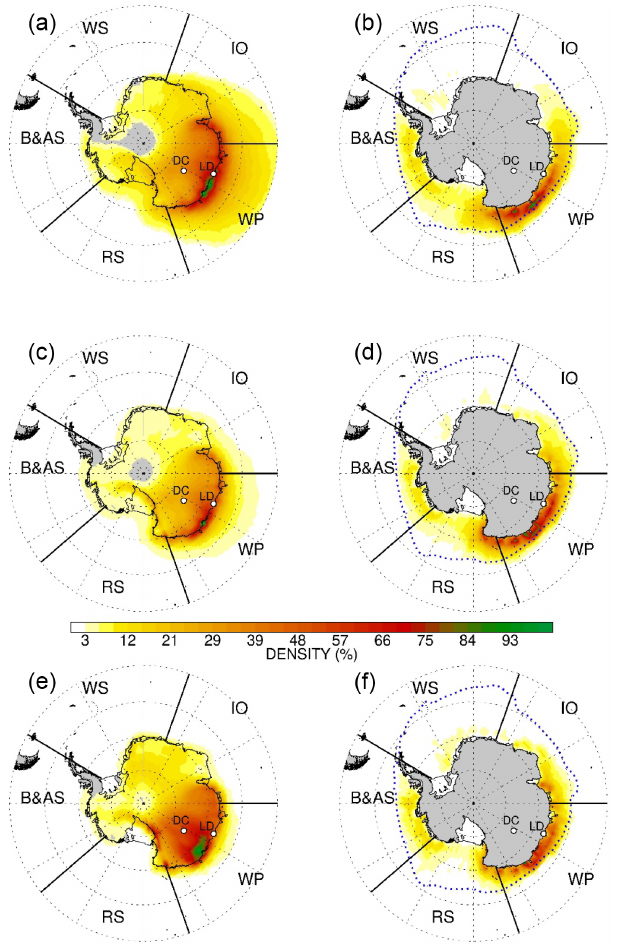
Figure 1. Five-day back-trajectory analysis of air masses arriving at the Dome C site for the period 1979–2018. The back trajectories are calculated at (a, b) 1000m, (c, d) 2000m, and (e, f) 3000m above Dome C model terrain height for the period 1979–2018. Maps are divided into five sectors: Indian Ocean (IO, 20–90 ◦ ), western Pa- cific Ocean (WP, 90–150 ◦ ), Ross Sea (RS, 160–230 ◦ ), and Belling- shausen and Amundsen seas (B and A, 230–20 ◦ ). Panels (a) , (c) , and (e) represent the sum of the total number of backward-trajectory points (i.e. hours) within the fifth and the second days found in each 1 ◦ × 1 ◦ grid cell. Panels (b) , (d) , and (f) represent backward- trajectory points (i.e. hours) within the MBL that cross areas with > 15% sea ice concentration at the given point of time. Each contour is normalised from 0 to 100 rescaling with respect to its maximum values and resampled to 0 . 5 ◦ × 0 . 5 ◦ grid mesh in order to increase readability. The grey dashed line represents the median ice edge in September (maximum extent) over the period 1979–2018.